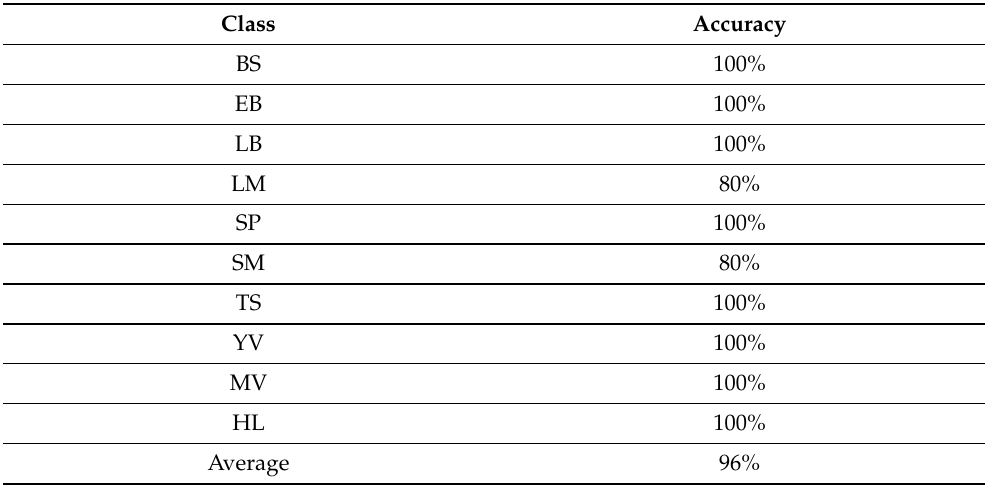
Table 8. Class-wise accuracy for the independent dataset. ‘BS’, ‘EB’, ‘LB’, ‘LM’, ‘SP’, ‘SM’, ‘TS’, ‘YV’, ‘MV’, and ‘HL’ stand for bacterial spot, early blight, late blight, leaf mold, Septoria leaf spot, spider mite, target spot, yellow curl virus, mosaic virus, and healthy leaves,